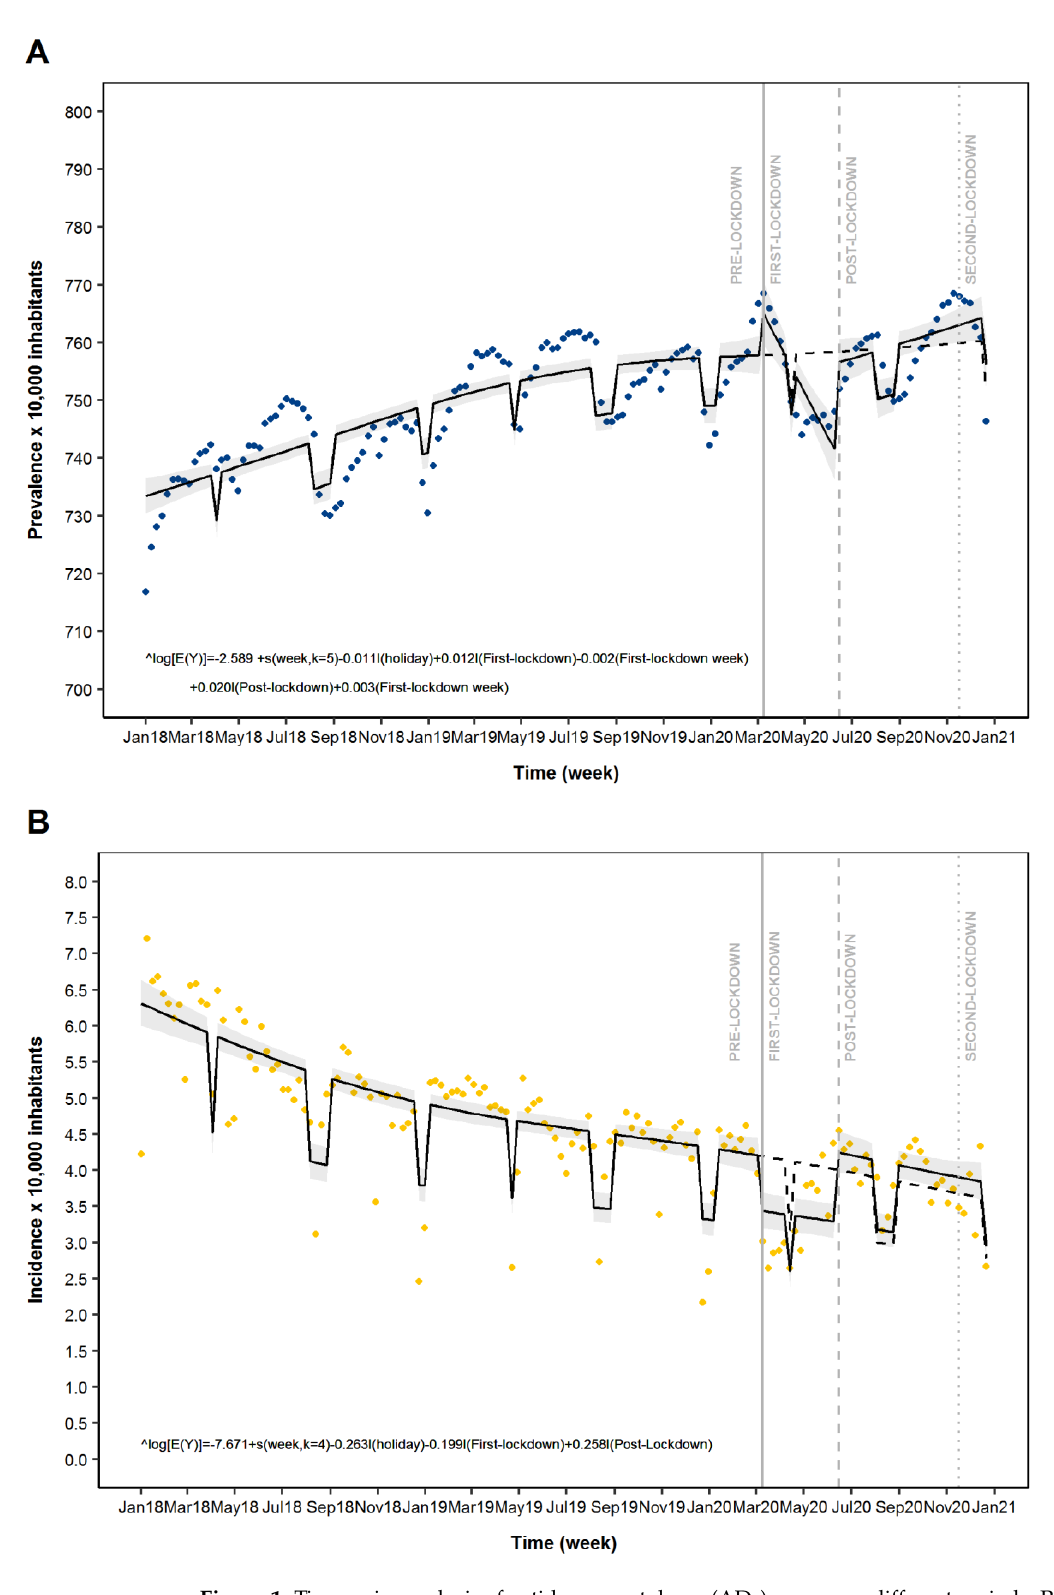
Figure 1. Time series analysis of antidepressant drugs (ADs) use across different periods: Pre-Lockdown, First-Lockdown, Post-First Lockdown and Second-Lockdown. Legend: Panel ( A ): Prevalence of AD use; Panel ( B ): Incidence of AD use. Blue dots: estimated prevalence of AD drug use; Orange dots: estimated incidence of AD drug use; solid line: predicted model based on estimated outcome; Grey zone: 95% CI of the predicted model; Dashed line: expected scenario in the absence of